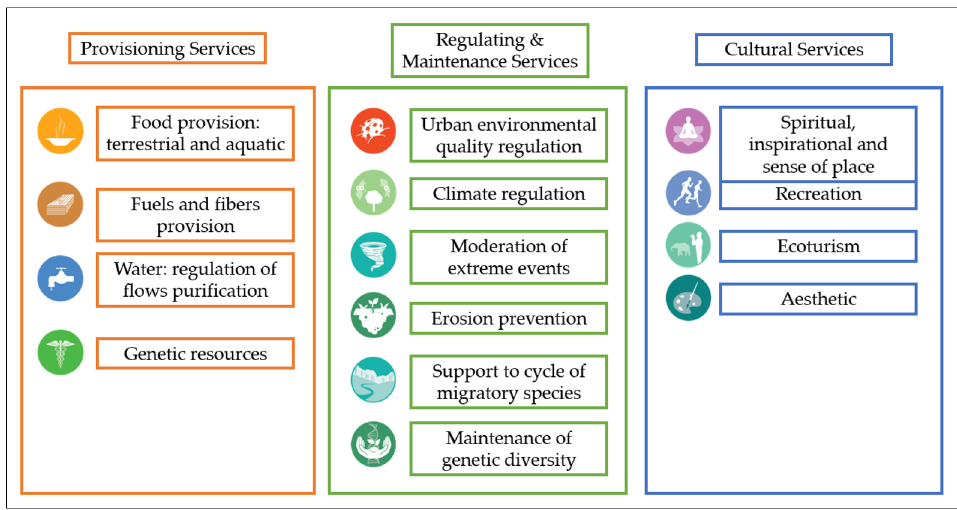
Figure 1. Ecosystem service values division